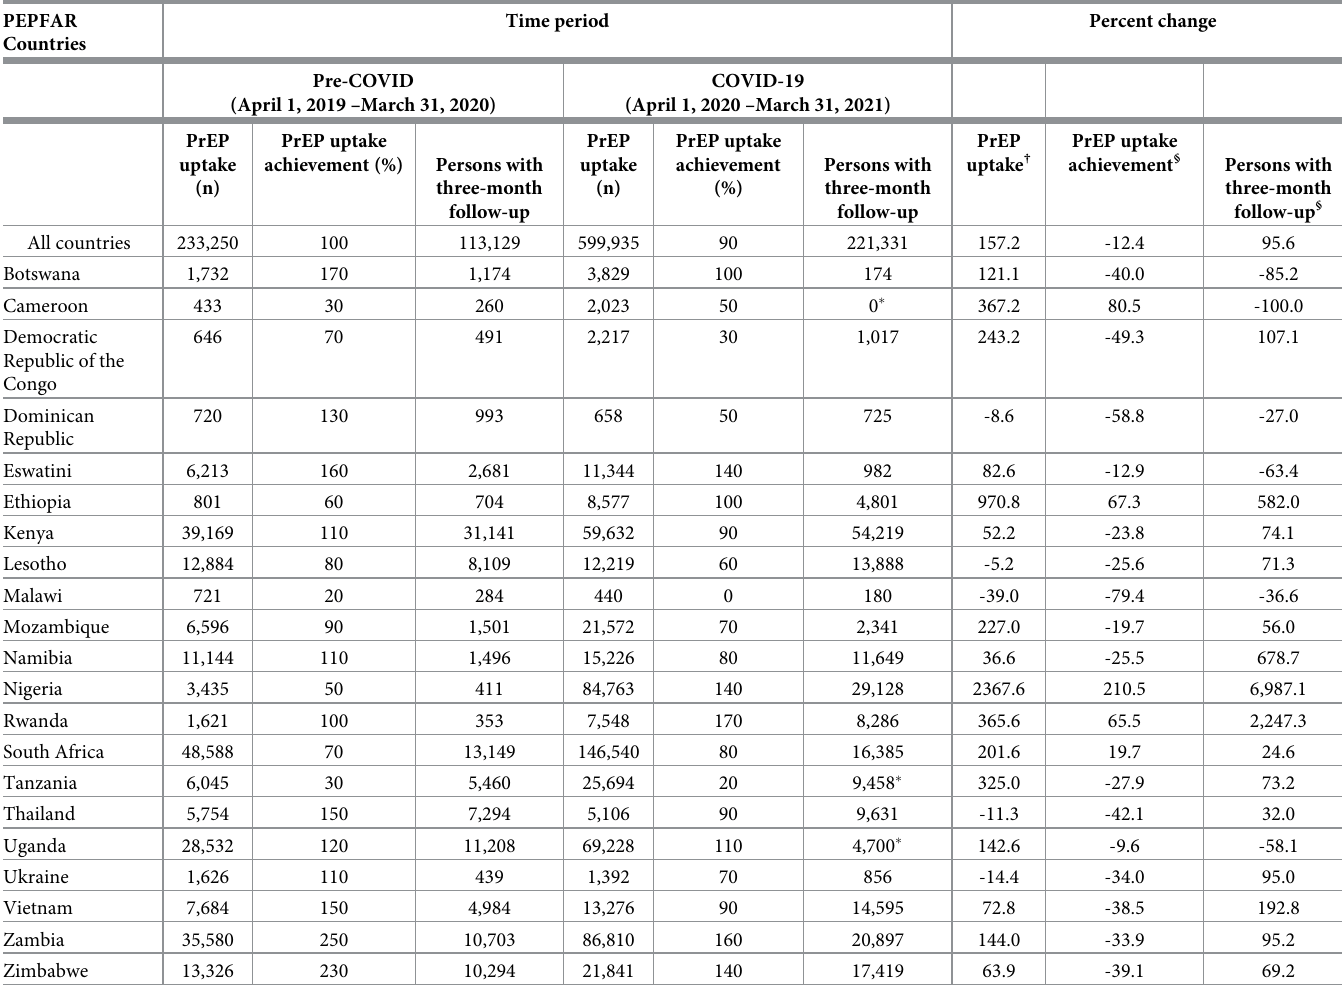
Table 1. New and current preexposure prophylaxis (PrEP) users in PEPFAR-supported countries, by pre-COVID-19 and COVID-19 time periods. PEPFAR